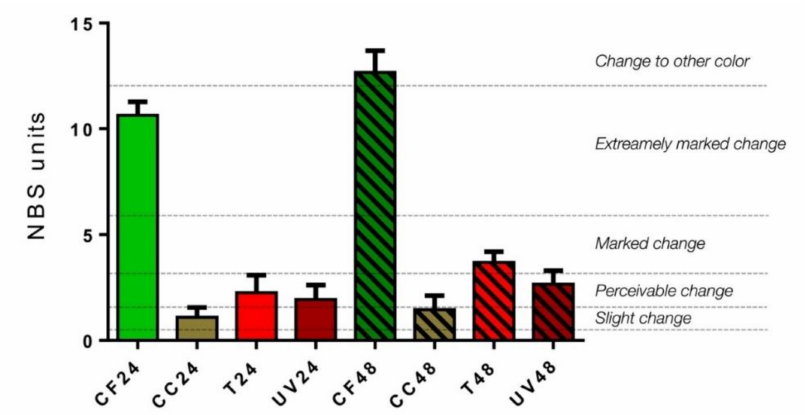
Figure 3. Colorimetric measurements (expressed by NBS system) of aligners subjected to the follow- ing aging treatment at 24 and 48 h: coffee (CF24 and CF48), Coca Cola ® (CC24 and CC48), tea (T24 and T48) and UV radiation treatments (UV24 and